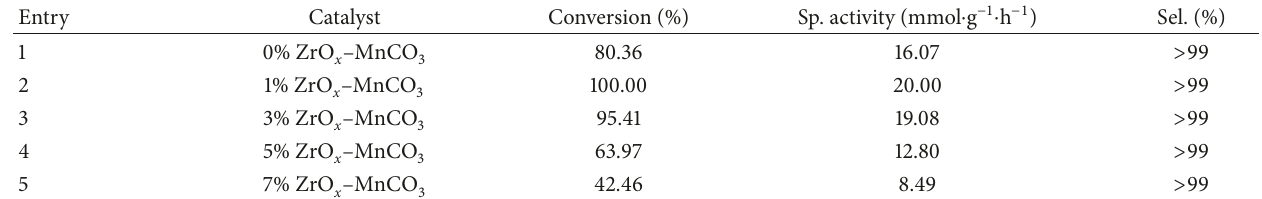
Table 2: Influence of different weight % of ZrO